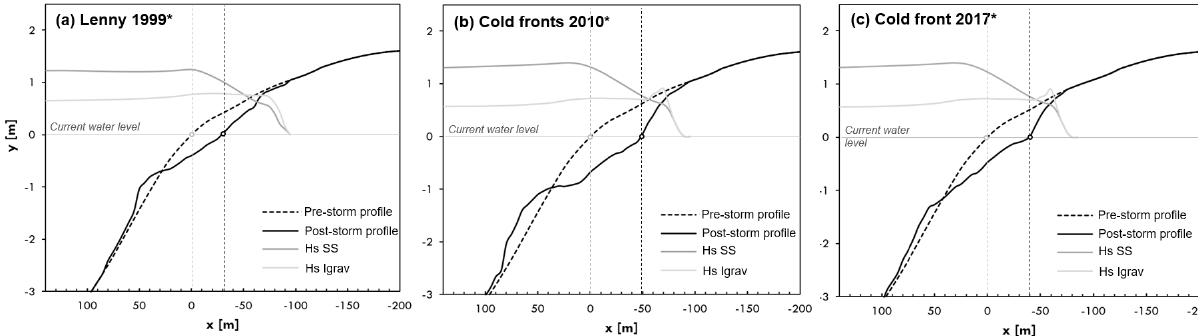
Figure 8. Time-averaged SS and infragravity (Igrav) waves and beach profiles before and after the storm for the most critical SLR condition (case no. 4). Vertical dotted lines represent beachfront before and after the storm.